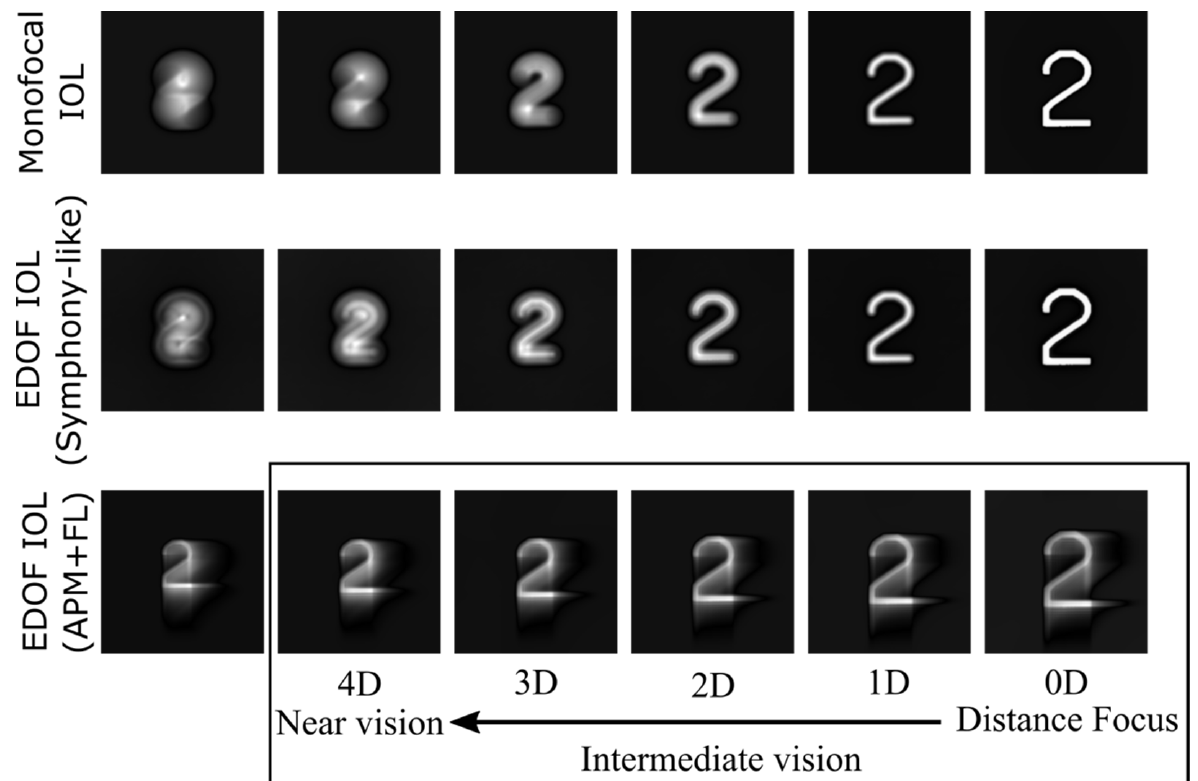
Figure 12. Images of an extended object of a monofocal IOL (top), an EDOF (Symfony-like) IOL (center), and a combined APM + FL with α = 80 = 251/ π , intended for an EDOF IOL (bottom), in different 𝑧′ -image positions. The rectangle highlights those in the useful range of vision at the IOL plane. Results obtained by numerical simulation.